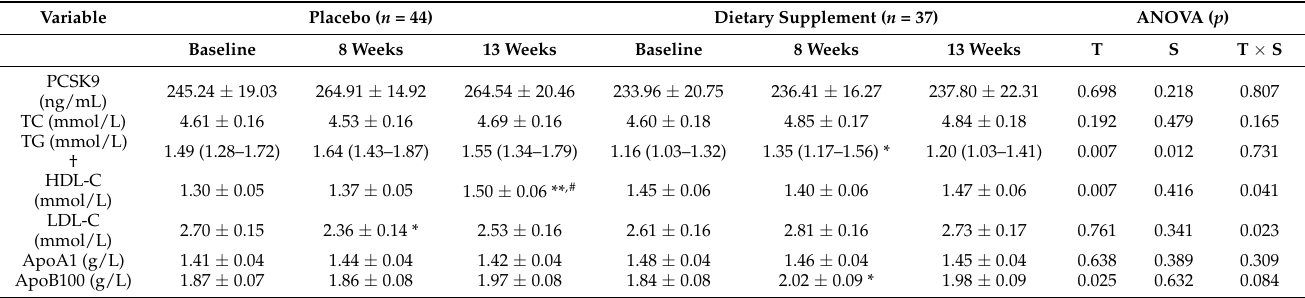
Table 2. Serum PSCK9 and lipid parameters at baseline, after 8 weeks and 13 weeks of supplementation. Variable Placebo ( n = 44) Dietary Supplement ( n = 37) ANOVA ( p ) Baseline 8 Weeks 13 Weeks